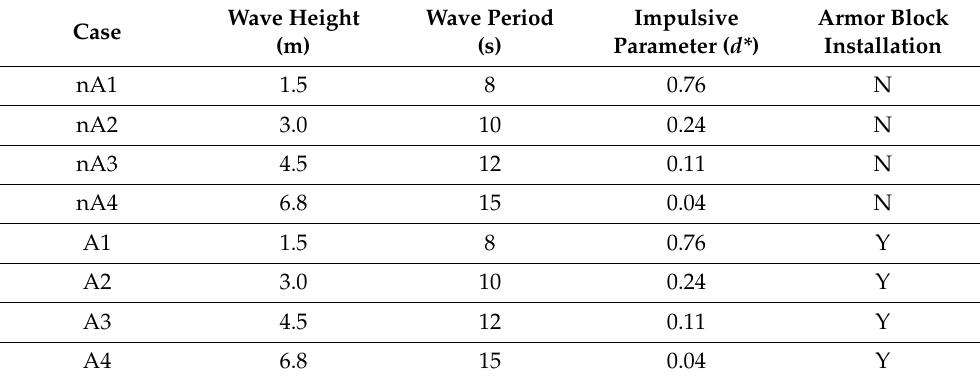
Table 2. List of simulation cases and corresponding